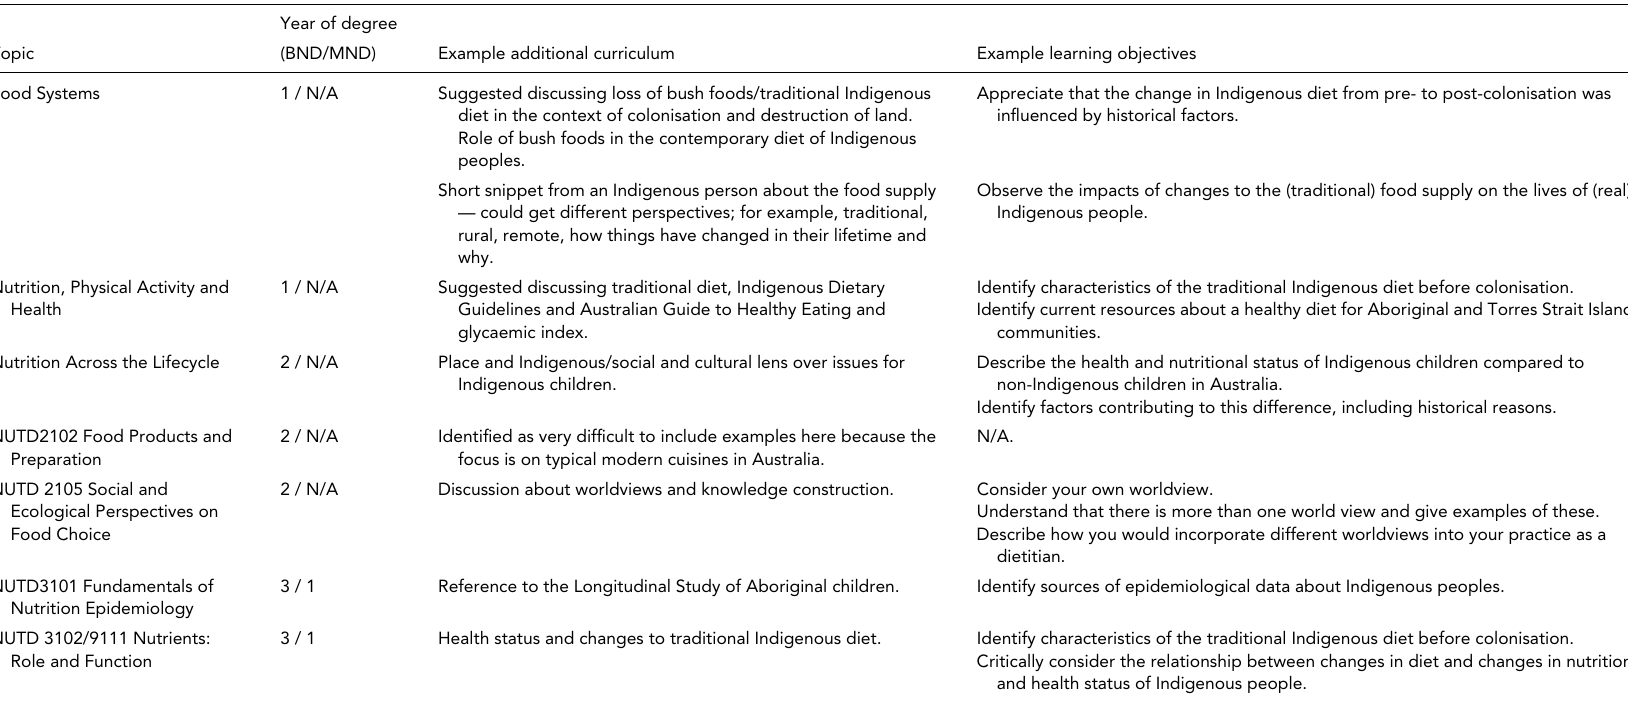
Suggestions for New Curricula in Bachelor (BND) and Masters (MND) of Nutrition and Dietetics Topics, Including Learning